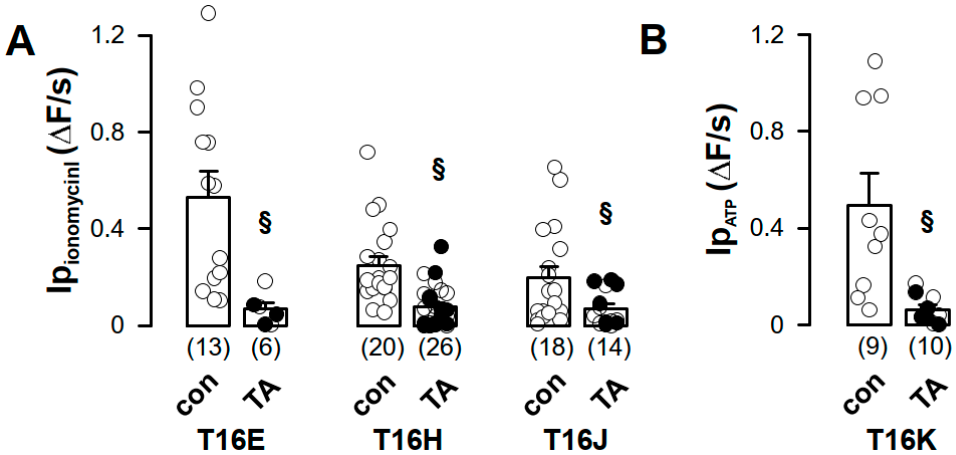
Figure 4. Increased iodide permeability induced by TMEM16 proteins was sensitive to tannic acid. ( A ) Ionomycin-induced iodide permeability (Ip ionomycin ) from TMEM16E-CFP-CAAX (T16E)-, TMEM16H-CFP-CAAX (T16H)- or TMEM16J-CFP-CAAX (T16J)-expressing HEK293 cells was